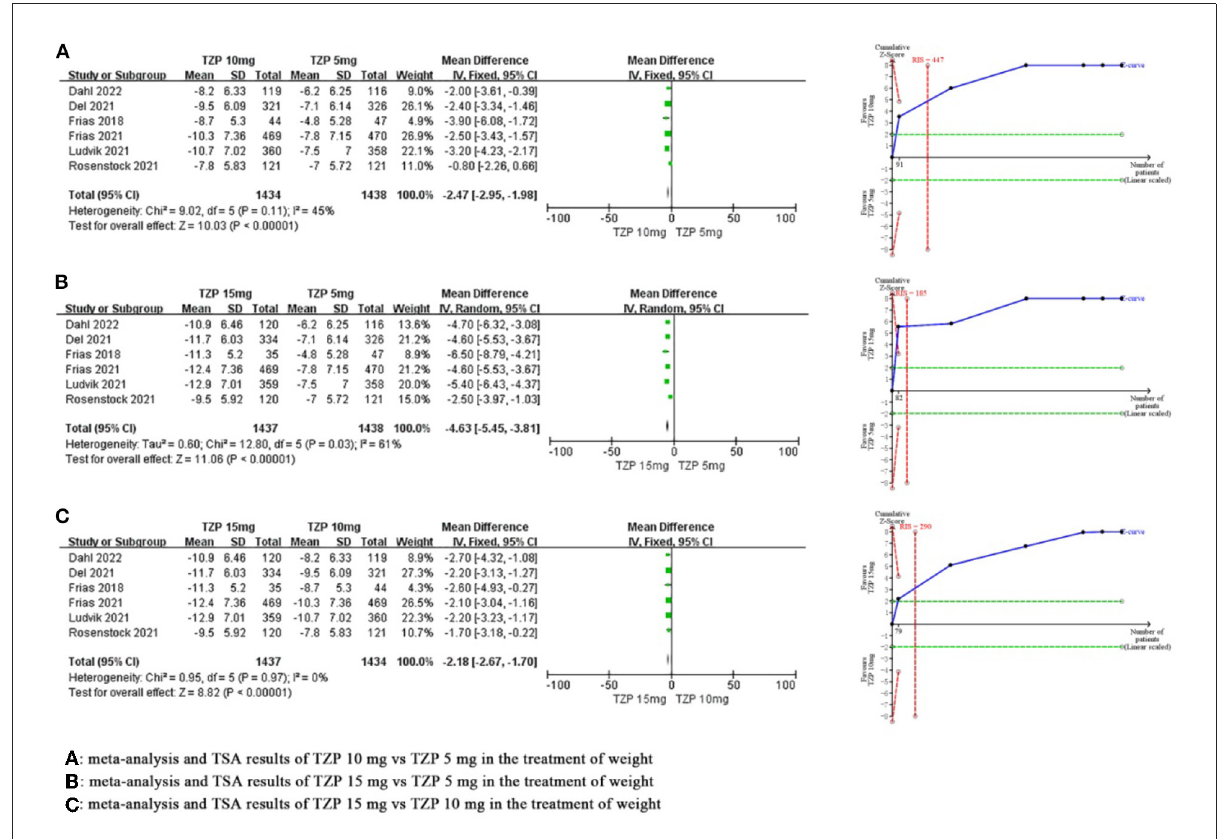
FIGURE5 Meta-analysis and TSA results of different doses of TZP for